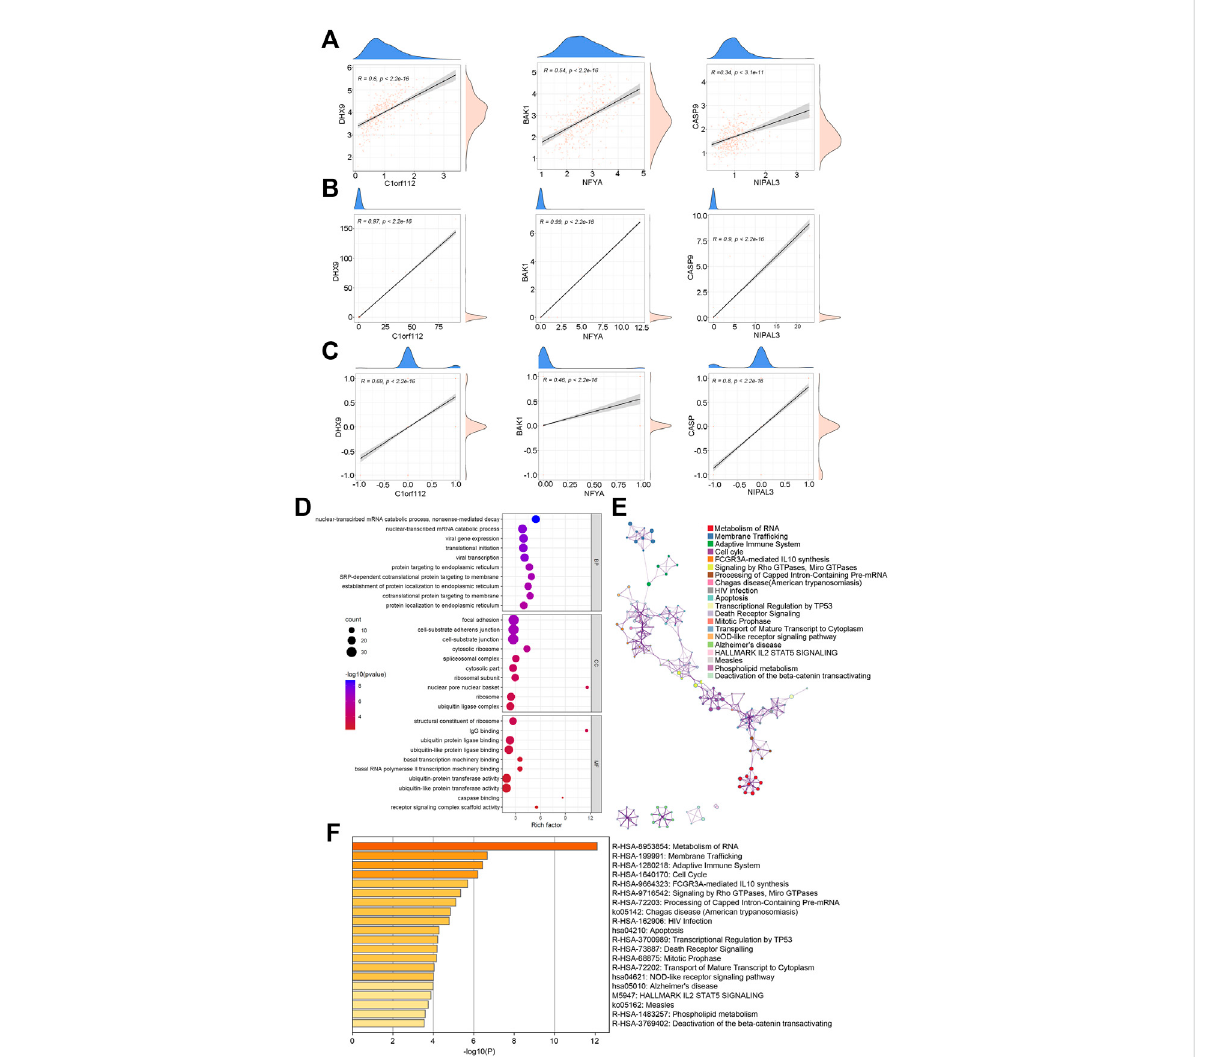
(D) Geneontology(GO)functionalclassi fi cationofcandidategenes.BP:biologicalprocess;CC:cellularcomponent;MF:molecularfunction. (E) The interaction network of top20 enriched pathways. (F) The top20 enriched pathways of candidate genes. The vertical axis represents enriched pathways, and the horizontal axis represents the p -value of enrich analysis of each